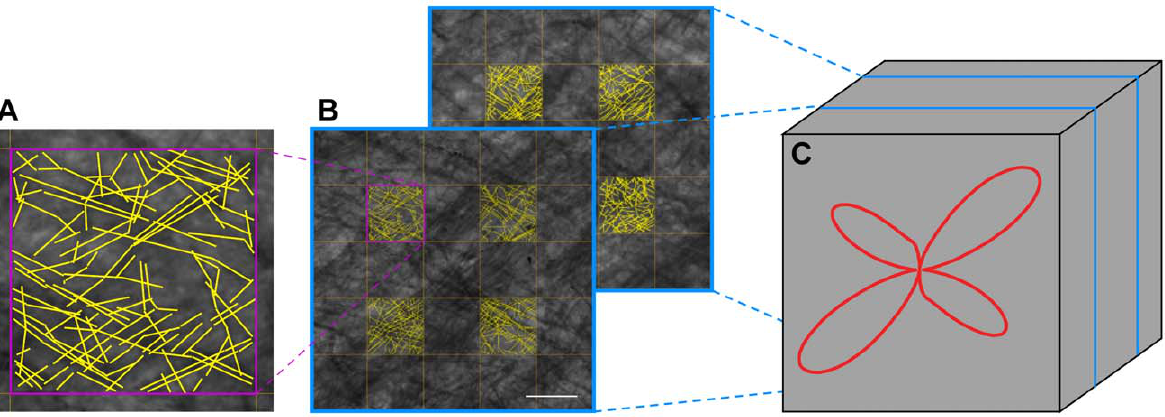
Figure 3. Computation of a single HIST-FOD from multiple myelin stained section images. ( A ) Myelin fiber orientations were manually traced as vector lines within 53 6 53 m m sample grids positioned above high-resolution images of myelin stained sections. ( B ) For each histological section, 4 sample grids were systematically positioned within a voxel domain. ( C ) For each QSI voxel, myelin fiber orientations were estimated from vector data collected from 8 sample grids across two histological sections spaced at 100 m m. This procedure was repeated for all voxels in both ROI-1 and 2. Scale bar, 50 m m.